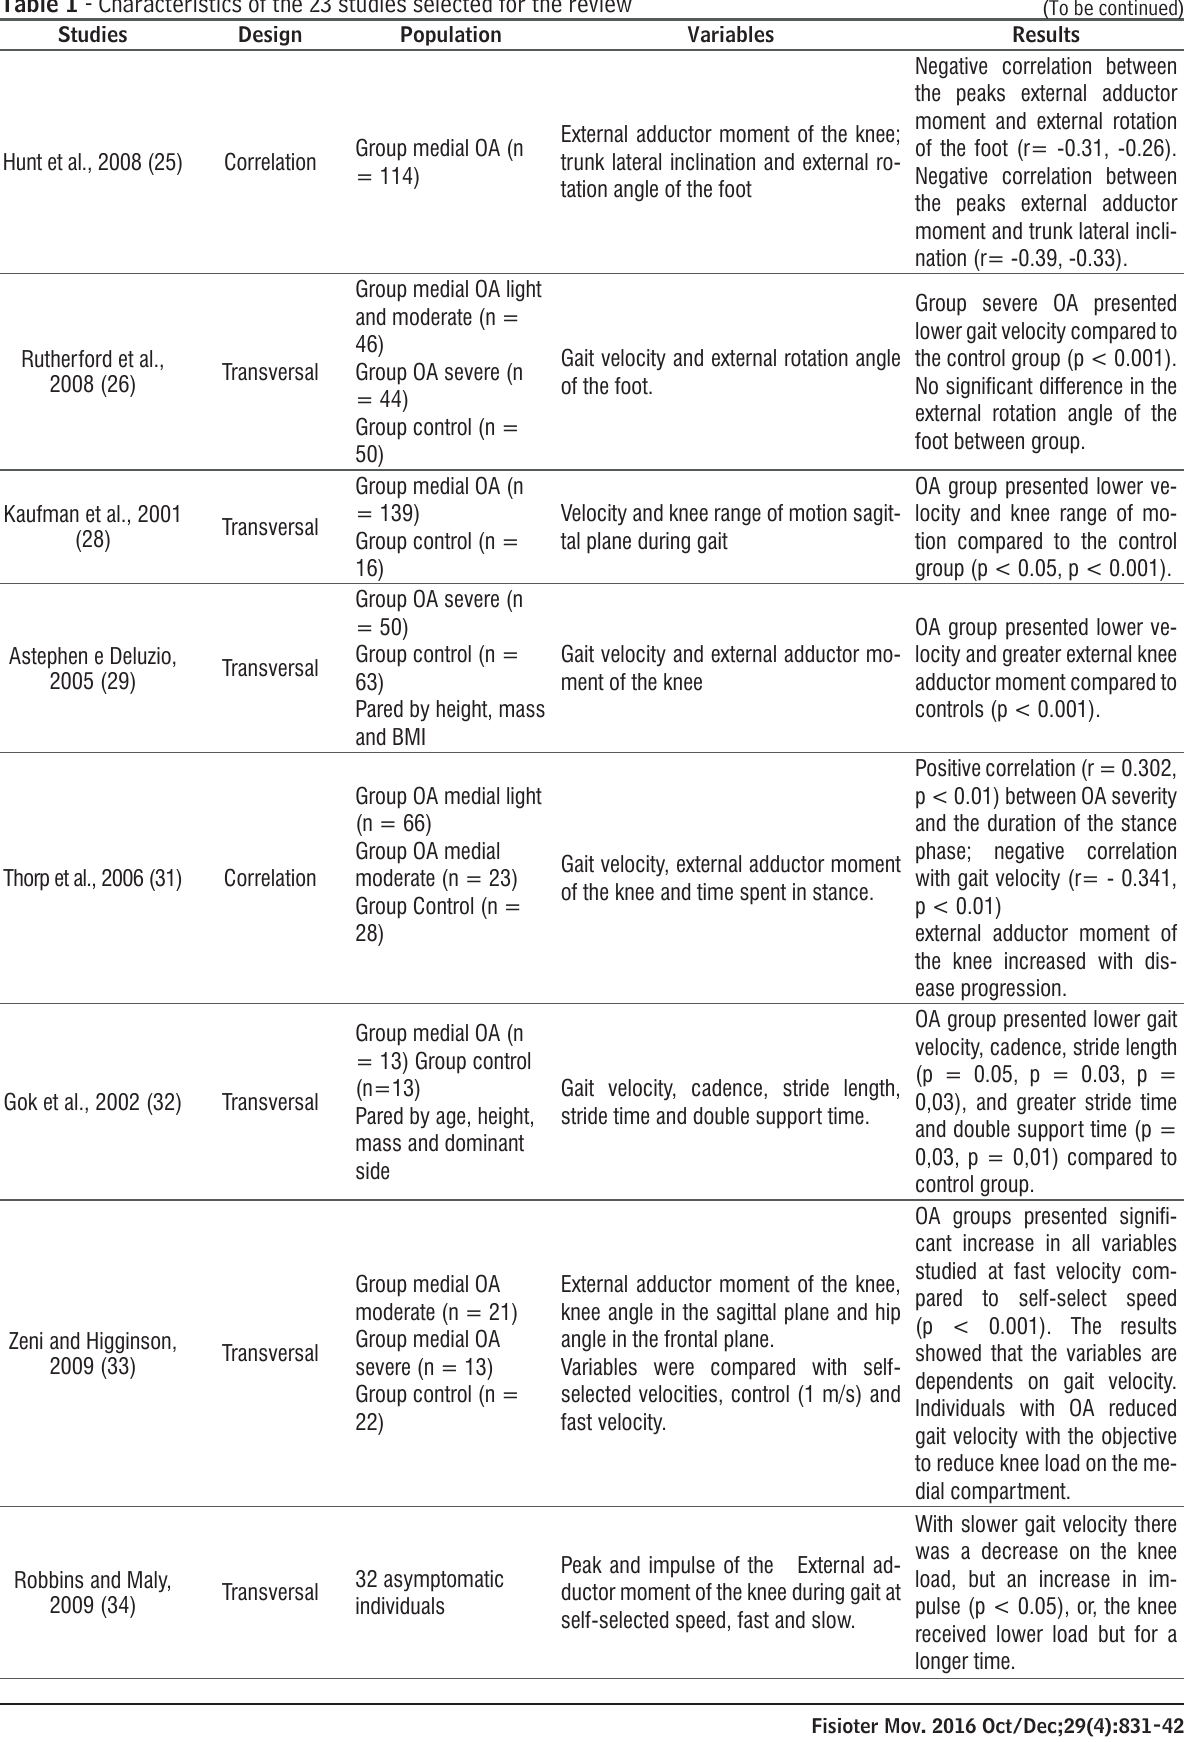
Table 1 - Characteristics of the 23 studies selected for the